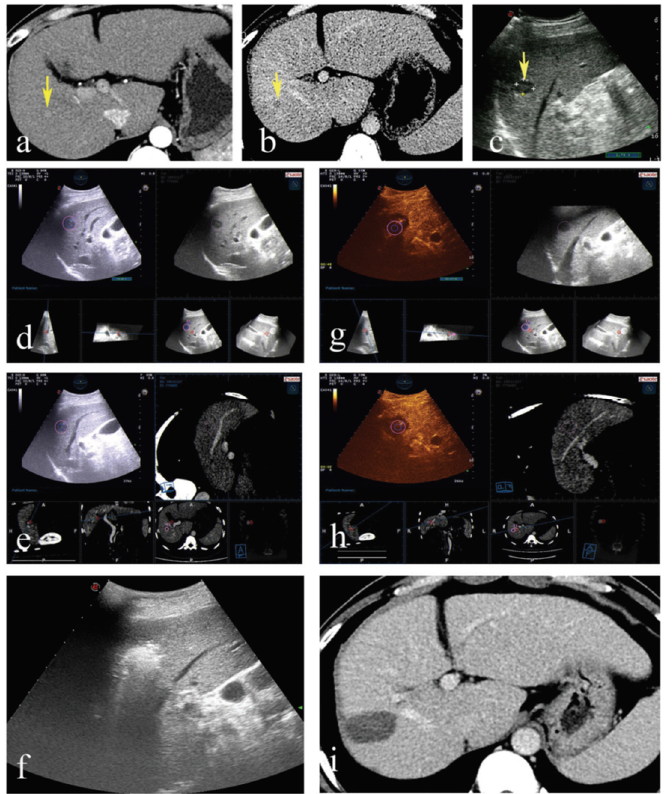
Figure 3. A 51-year-old male. ( a , b ) Contrast-enhanced computed tomography (CT) indicates a liver tumor located in segment 7. Arterial enhancement and delay washout were observed. ( c ) A hypoechoic lesion in Ultrasonography (US). ( d ) Real-time US was successfully matched with immediately acquired pre-ablation 3DUS. ( e ) Real-time US was matched with pre-ablation CT volume images successfully. ( f ) Ablation was applied under the guidance and monitoring of US. ( g ) Contrast-enhanced ultrasonography (CEUS) was performed and fused with pre-ablation 3DUS. The ablation zone completely covered the target tumor and the 5-mm ablative margin. ( h ) CEUS fused with pre-ablation CT indicated the ablation zone completely covered the target tumor and the 5-mm ablative margin. ( i ) Subsequent contrast-enhanced CT within three months confirmed that the tumor had been completely ablated [164].